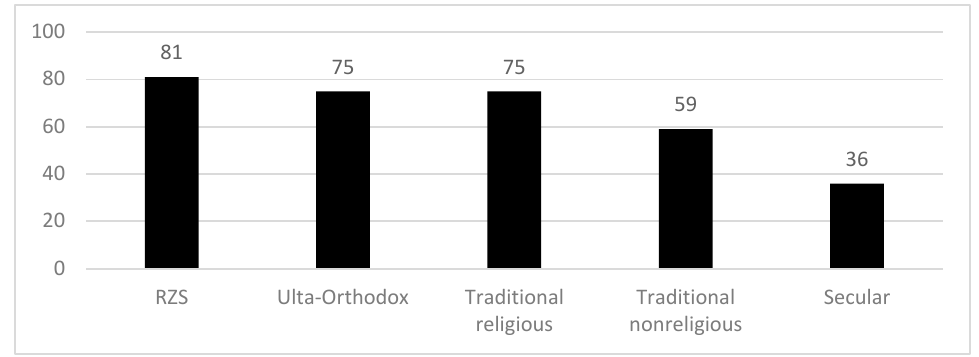
Figure 14. Agree that critical national decisions on society and economy should be made based on Jewish majority only (%) Source: Hermann et al., A Conditional Partnership: Jews and Arabs, Israel 2021.